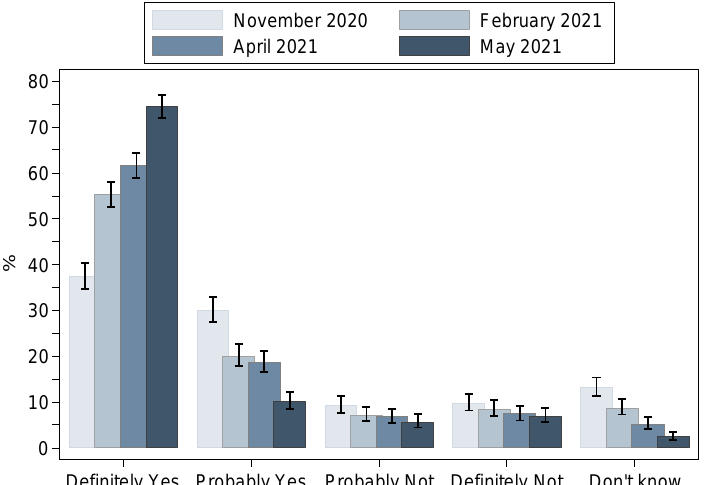
Figure 1. Responses concerning COVID-19 vaccination intention in four cross-sectional surveys implemented in the adult population of Greece during the pandemic (proportions and 95% confidence intervals). The category “Definitely yes” includes also those already vaccinated. The proportions are standardised to the age and sex distribution of the adult population in